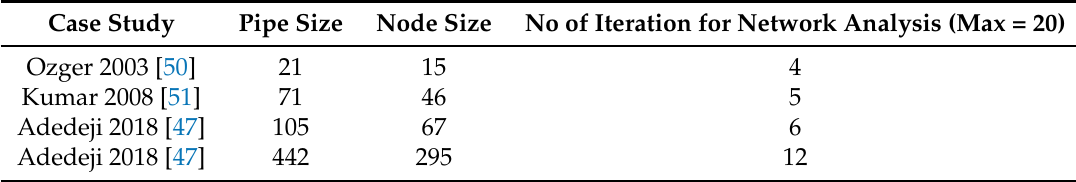
Table 8. Comparison of Case Study and Iterative Period.